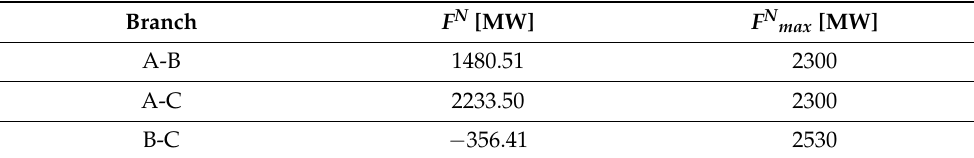
Table 2. Power flows on inter-area lines for N100 scenario.